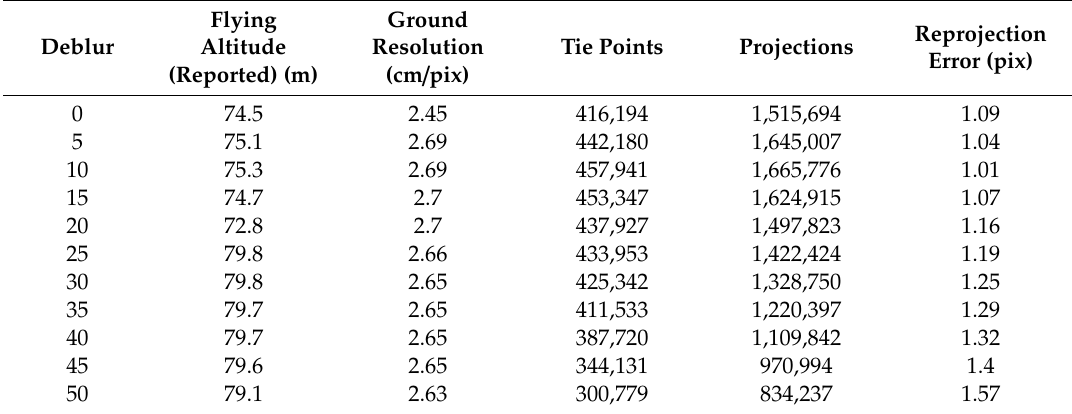
Table 6. Reported survey data for a deblurred dataset.